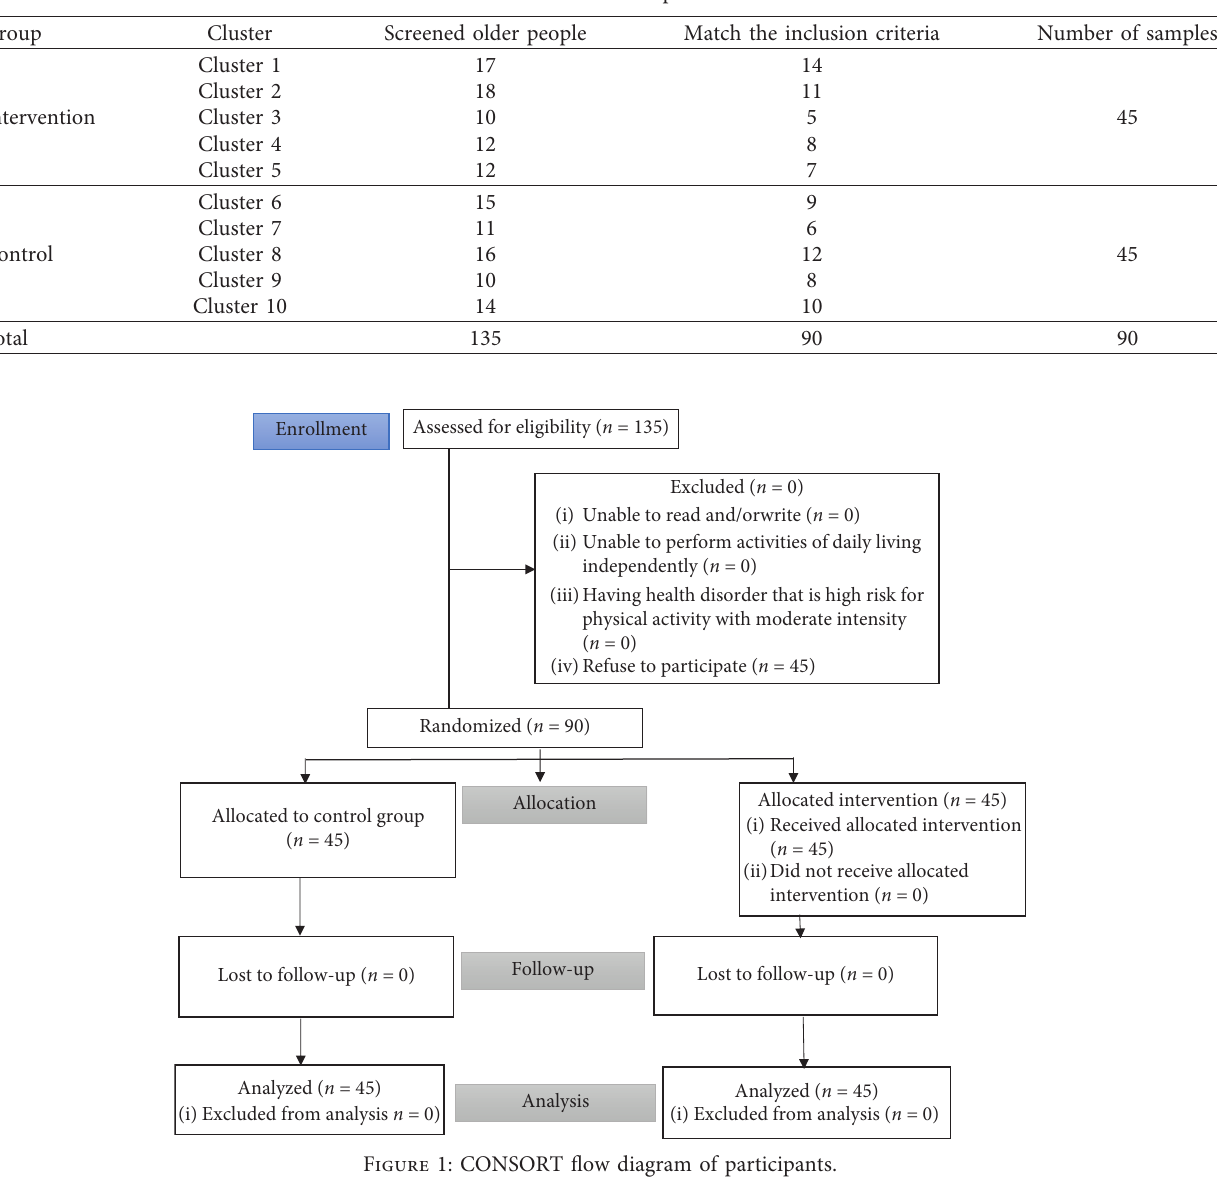
Table 1: Number of research samples for each cluster.